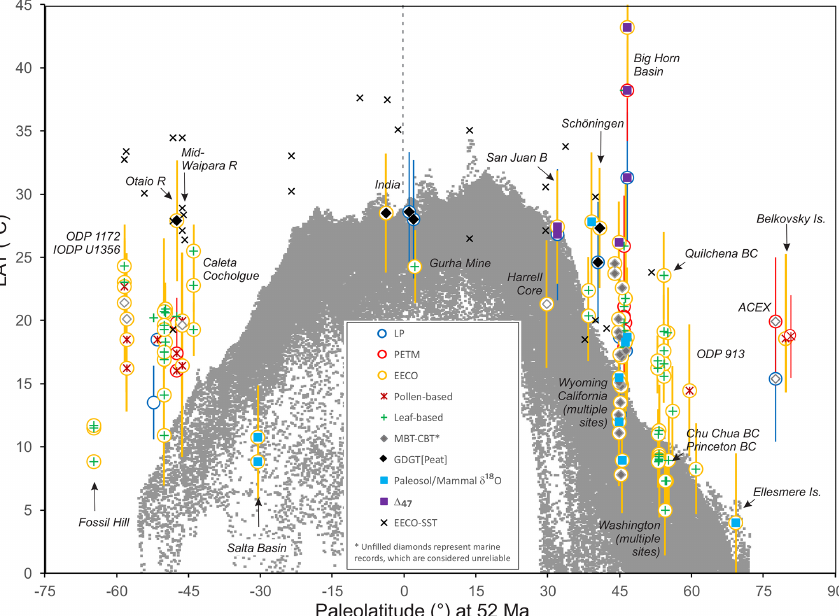
Figure 9. LAT estimates for the three time slices differentiated by broad proxy categories. These data are tabulated in Supplement Data File 7. The SST data for the EECO is shown for comparison. Grey data cloud represents modern LAT measurements derived from same source cited for Fig.